Question: How would you classify this visualization?
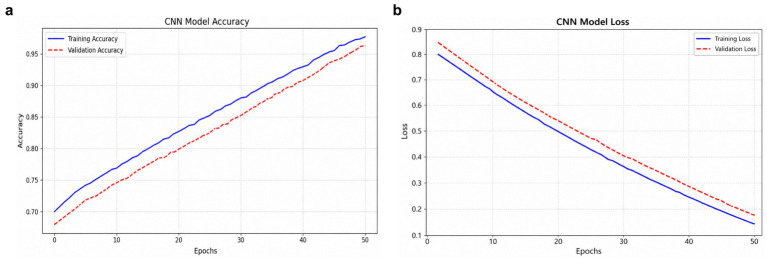
Answer: line